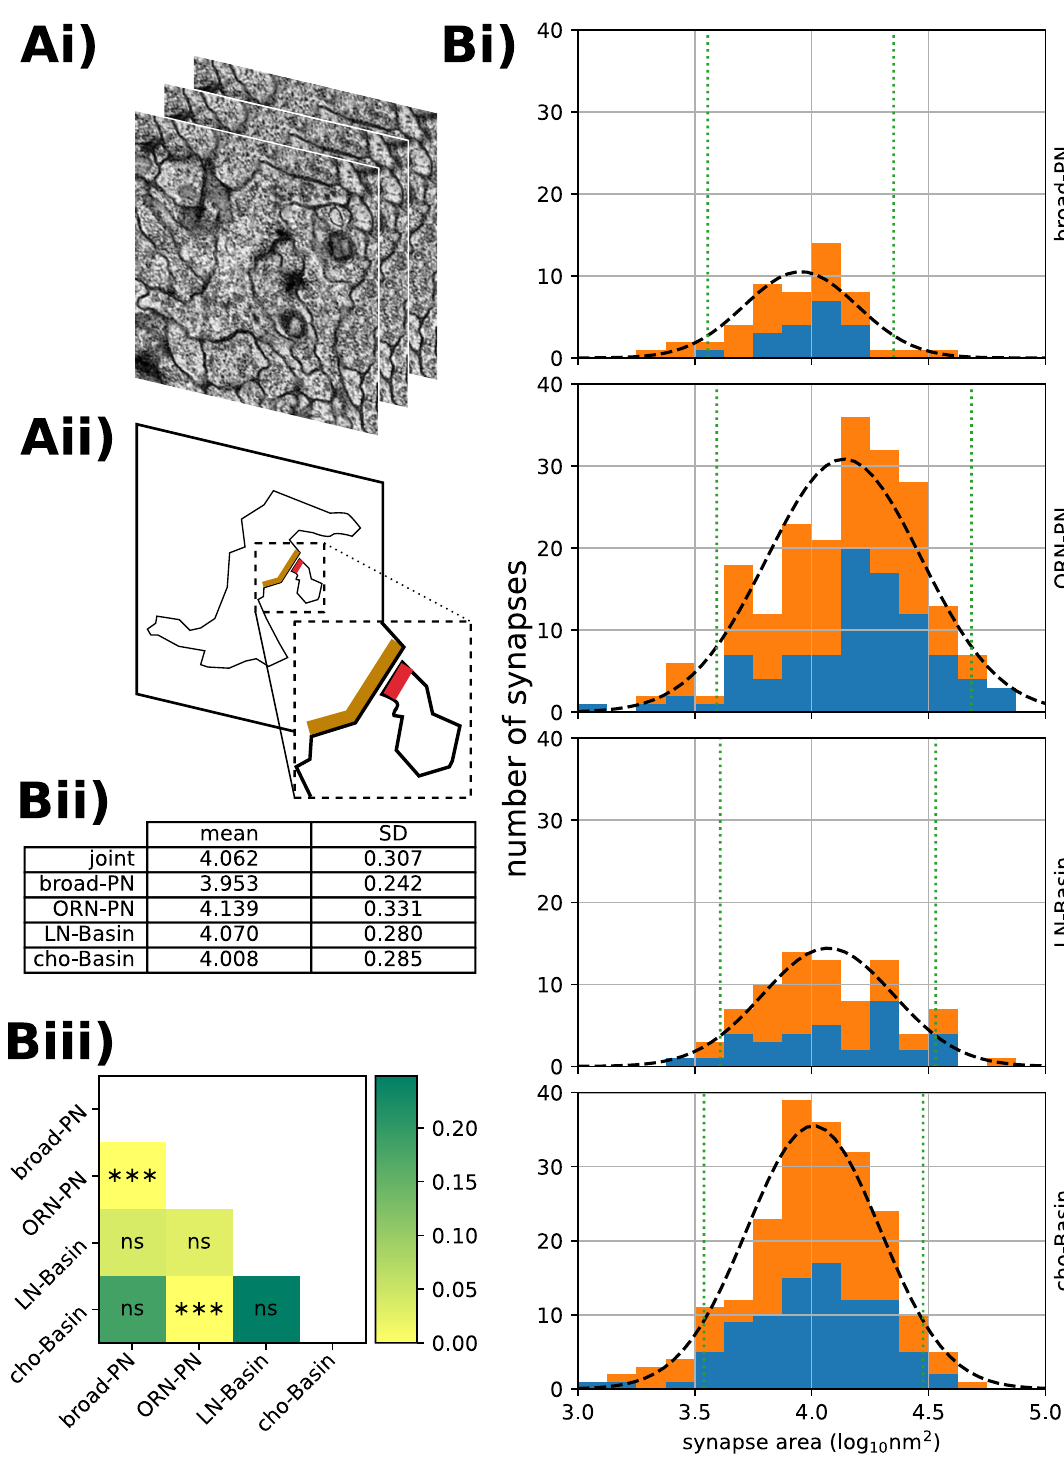
Fig 2. Results of synaptic area labelling. Ai) The ssTEM images upon which the analysis is based. Aii) A schematic showing the plane of a neurite sectioned in the top image, and the pre- and post-synaptic sites of that neurite and one of its partners, in orange and red respectively. Note the T-bar, cleft and and postsynaptic membrane specialisation. Bi) For each of the four circuits, the distribution of synaptic areas on a log 10 scale. The number of synapses targeting a left-sided neuron are shown in blue; right-sided in orange. Each is overlaid with the best-fitting normal distribution (black dashed line) and 90% confidence interval (green dotted line). Bii) Table of normal distribution parameters, in log 10 nm 2 to 3 decimal places. Biii) Raw p -values (colouring) and FWER corrected [34] significance levels for pairwise ranksum comparisons of circuit synapse area